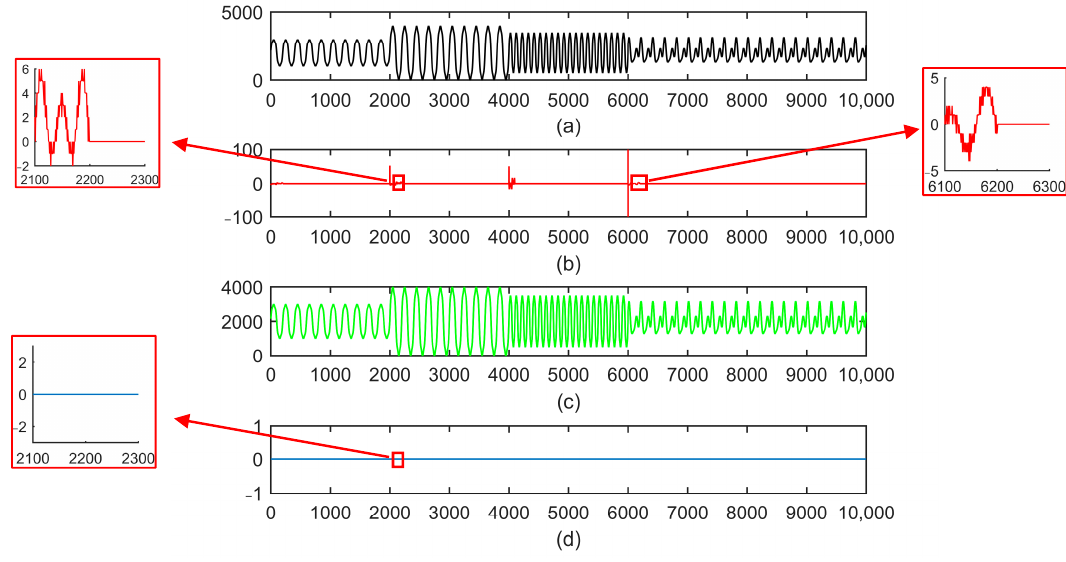
Figure 8. ( a ) Original signal ( b ) Coding output ( c ) Decoding output ( d ) Error between the decoding output and the original signal.